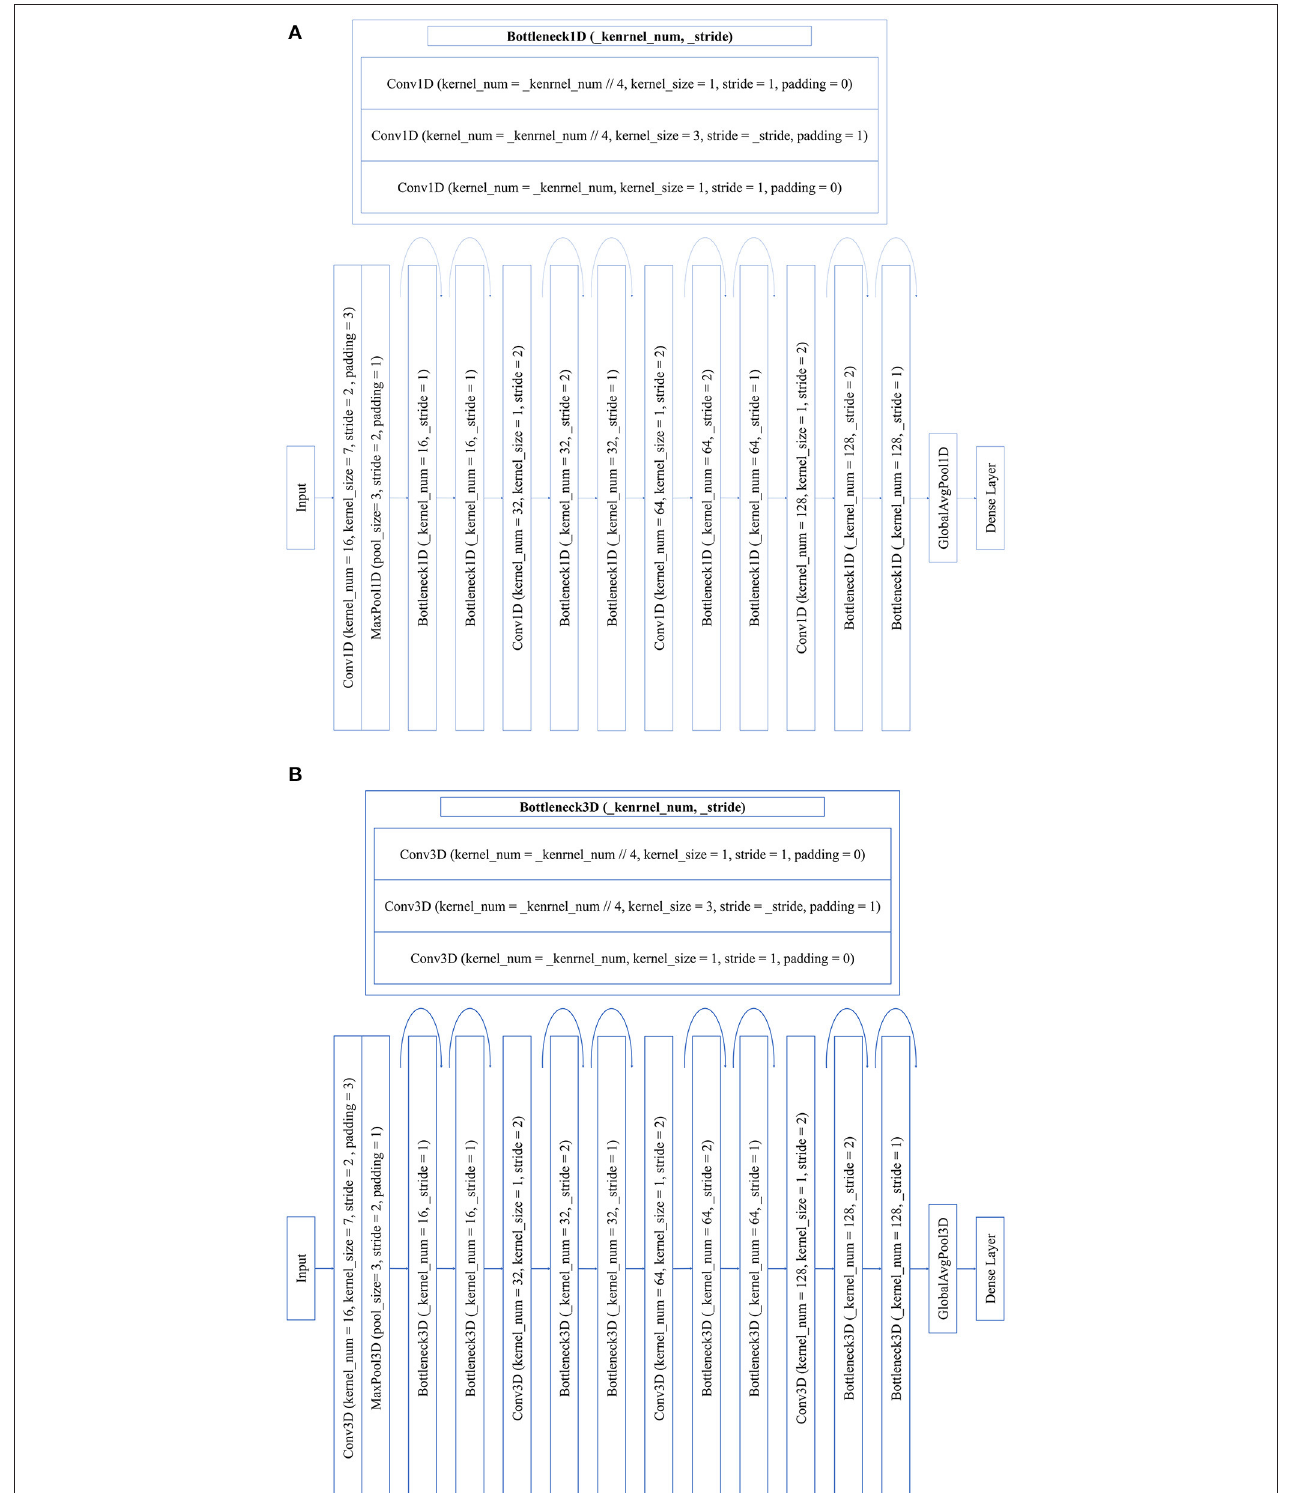
FIGURE 2 | ResNet architectures for 1D spectra (A) and residual neural network (ResNet) architectures for 3D hyperspectral image (B) . The bottleneck block is defined by three convolution layers.